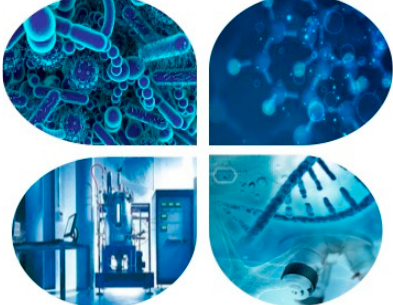
Figure 1. Illustration of the diversity of scientific fields underlying microbial biotechnology (clockwise): microbiology, chemistry, genomic and industrial technologies.